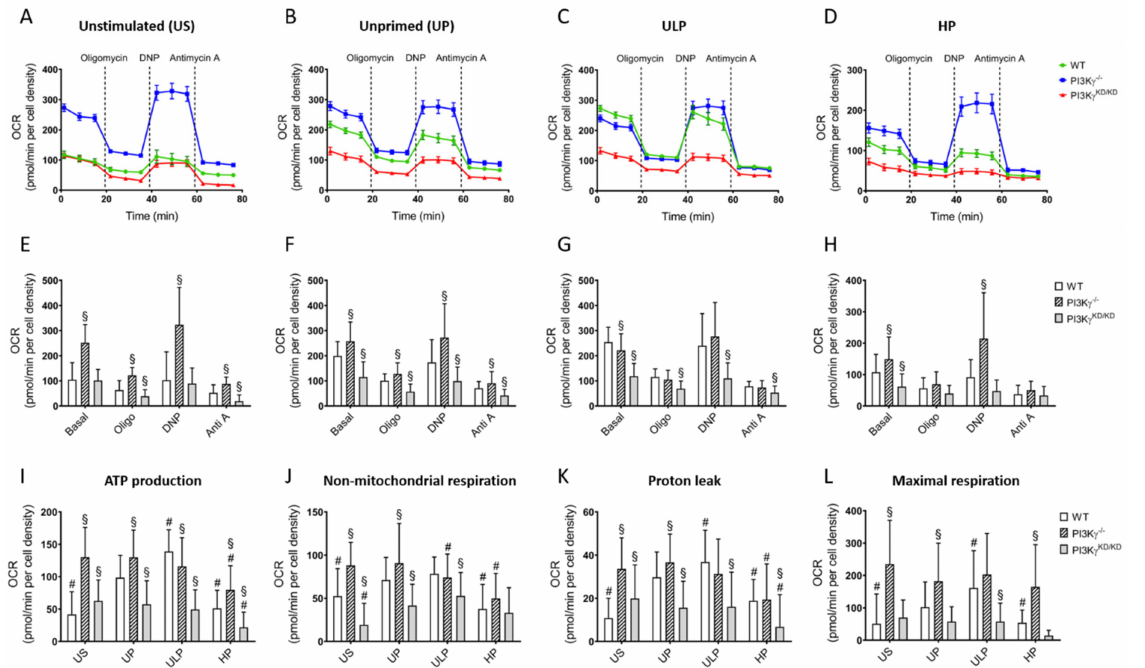
Figure 4. Lipid kinase-independent function of PI3K γ mainly mediates control of microglial oxygen consumption (OCR). Microglia isolated from newborn mice (wild-type, open columns; PI3K γ -/- , hatched columns; PI3K γ KD/KD , dark gray columns; n = 5–6, repeated measurements, respectively) were primed initially by ultra-low (ULP, 1 fg/mL) or high (HP, 100 ng/mL) doses of LPS, followed by the second stimulation (day 6) with 100 ng/mL LPS. Time-dependent OCR ( A – D ) dynamics were assayed using a Seahorse assay and quantified under unstimulated ( E ), unprimed ( F ), ULP ( G ) and HP ( H ) conditions. ( I ) Mitochondrial ATP production, ( J ) non-mitochondrial respiration, ( K ) proton leak and ( L ) maximal respiration were calculated from OCR values. Unstimulated microglia (US) served as the negative control. Data from ( A – D ) are given as means ± SEM, data from ( E – L ) are represented as means + SD, #§ p < 0.05, # vs. unprimed condition, § vs. the wild-type